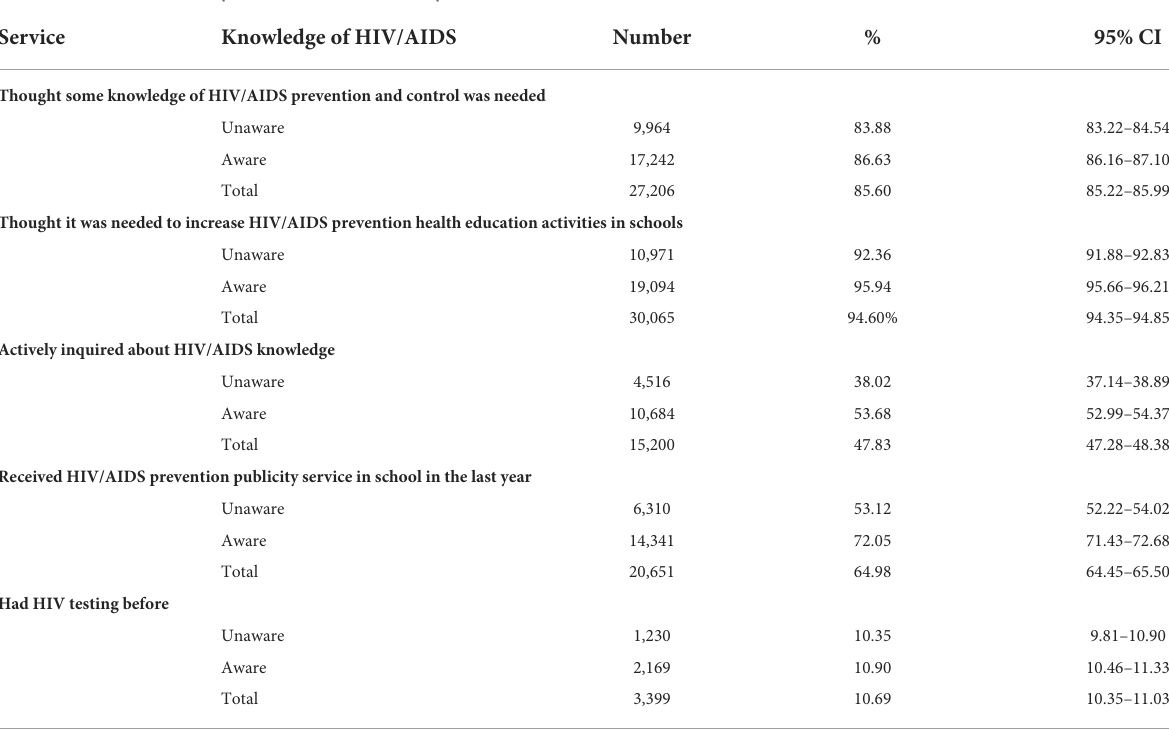
TABLE 14 Use of HIV/AIDS prevention services in the past ( n =